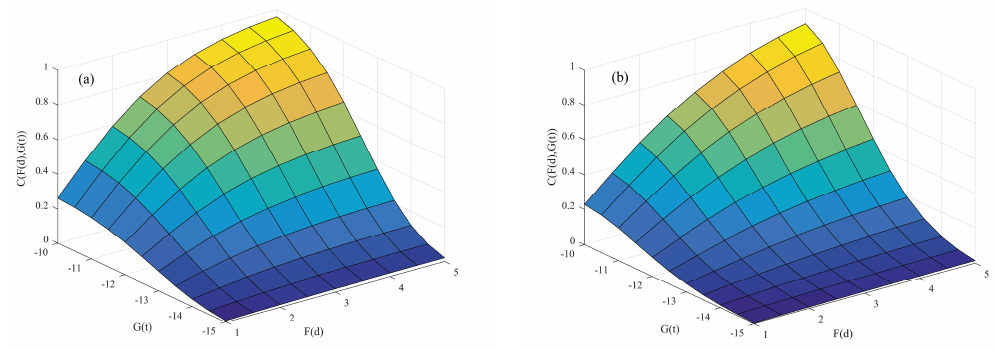
Figure 3. Joint cumulative distributions of intensity and duration for winter low temperature events at Yanqing station for the study periods: ( a ) 1978–1998, and ( b )